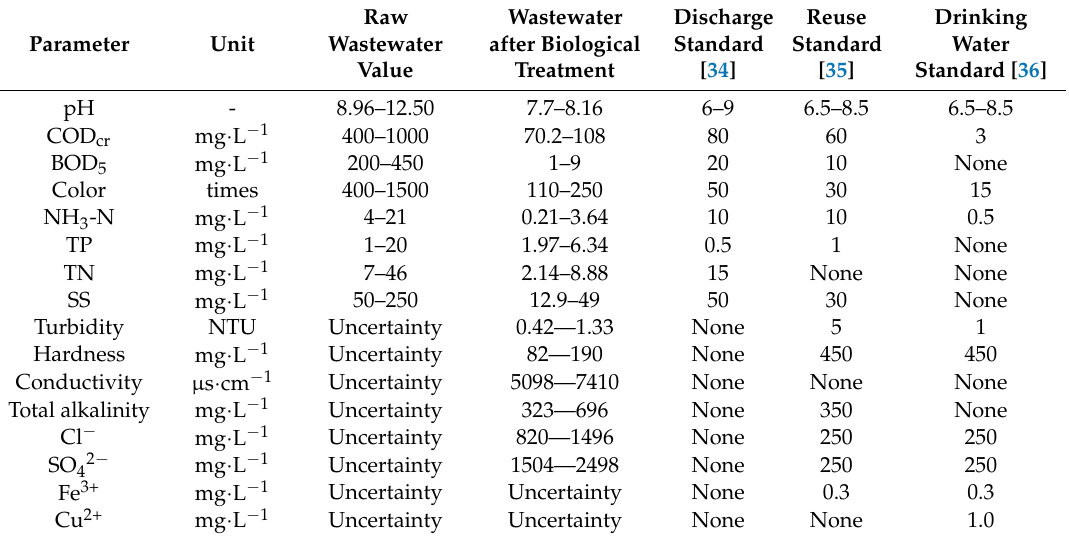
Table 1. Pollutant contents of influents from a textile wastewater treatment plant and corresponding standards (COD cr : chemical oxygen consumption; BOD 5 : biochemical oxygen demand; TP: total phosphorus; TN: total nitrogen; SS: suspended